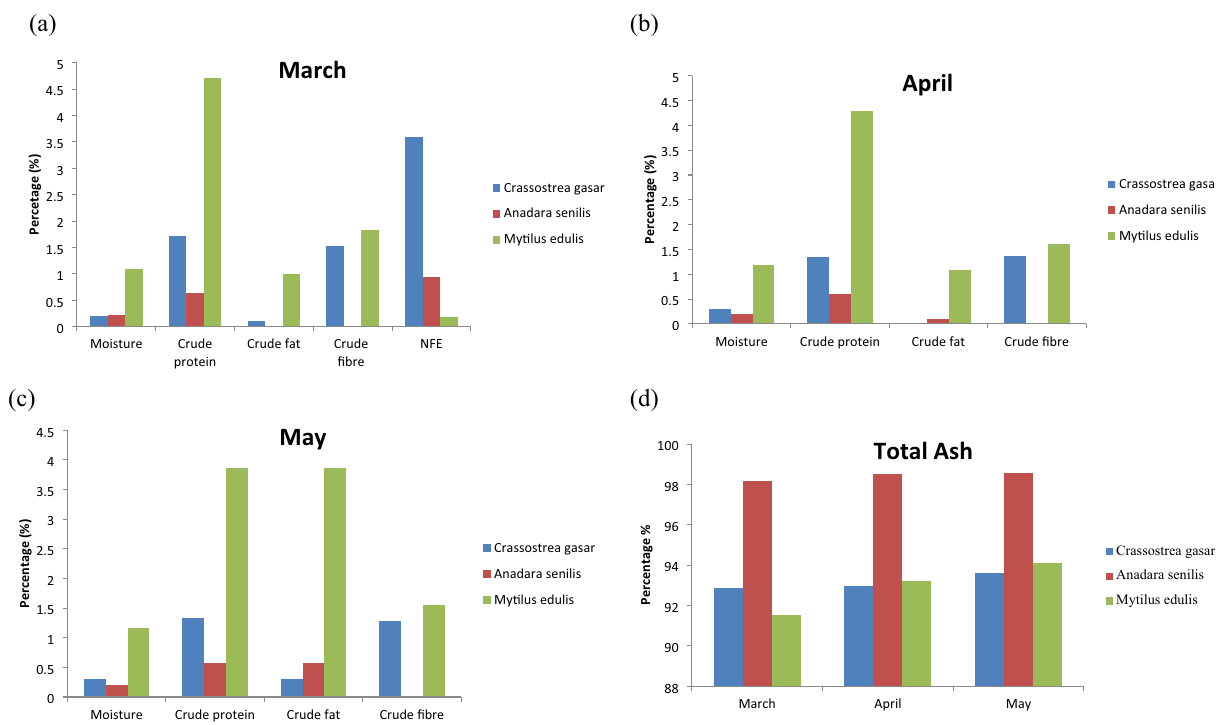
Fig. 2 Variations in the proximate composition of Crassostrea gasar , Anadara senilis , and Mytilus edulis in a March, b April, c May 2021, d Total Ash content in Crassostrea gasar , Anadara senilis , and Mytilus edulis in March, April, and May